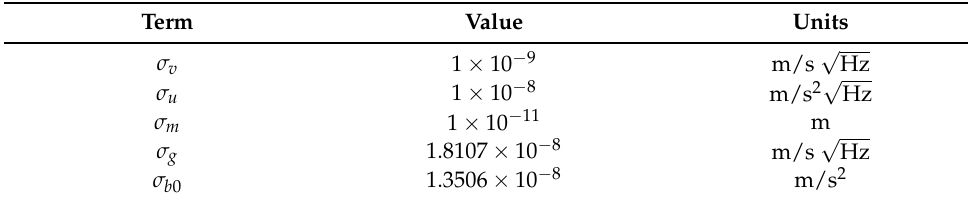
Table 2. Random process parameters.